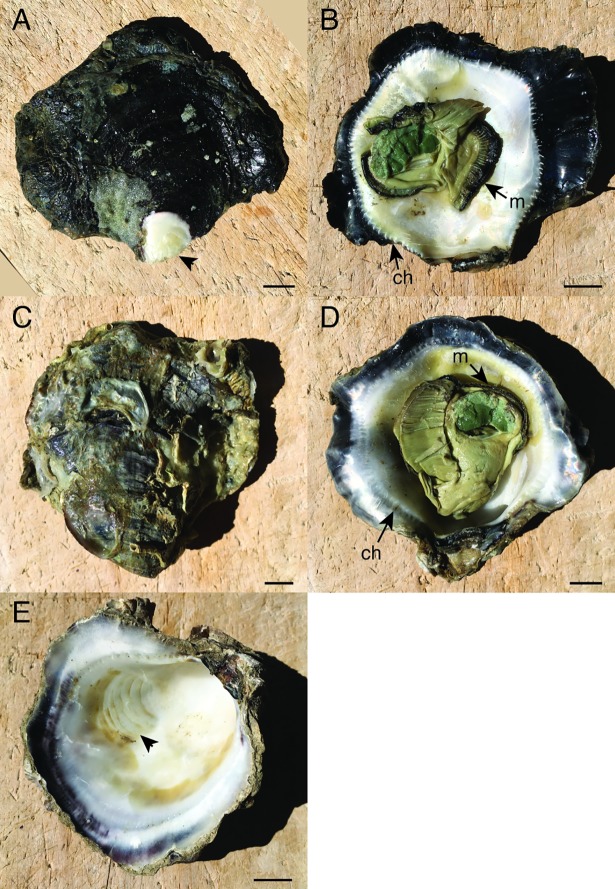
Morphology of the black-lip oyster.The sample has been stored in ethanol, causing some shift in colour within the internal soft tissues. A. Upper surface of the right valve, showing intense dark pigmentation. The outer shell layer has been chipped away at the umbo (arrowhead). B. Inner surface of the right valve. The dark outer shell margin is sharply separated from the white internal surface by large, obvious chomata (ch). The mantle edge is darkly pigmented (m). C. Outer surface of the deeply-cupped left valve. D. Inner surface of the left valve, showing a dark outer shell margin and obvious chomata, and dark pigmentation in the mantle E. Inner surface of the left valve of a second specimen, with soft tissues removed to display the adductor scar (arrowhead). Scale bar = 10mm.